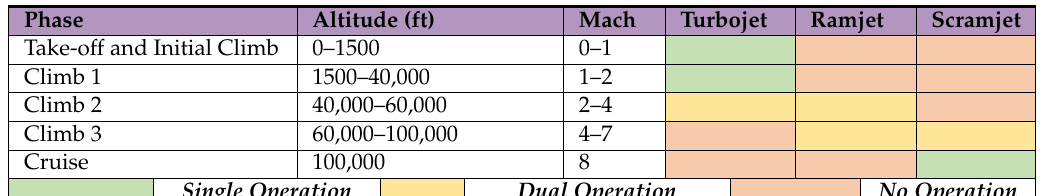
Table 1. Concept aircraft fundamental flight profile.